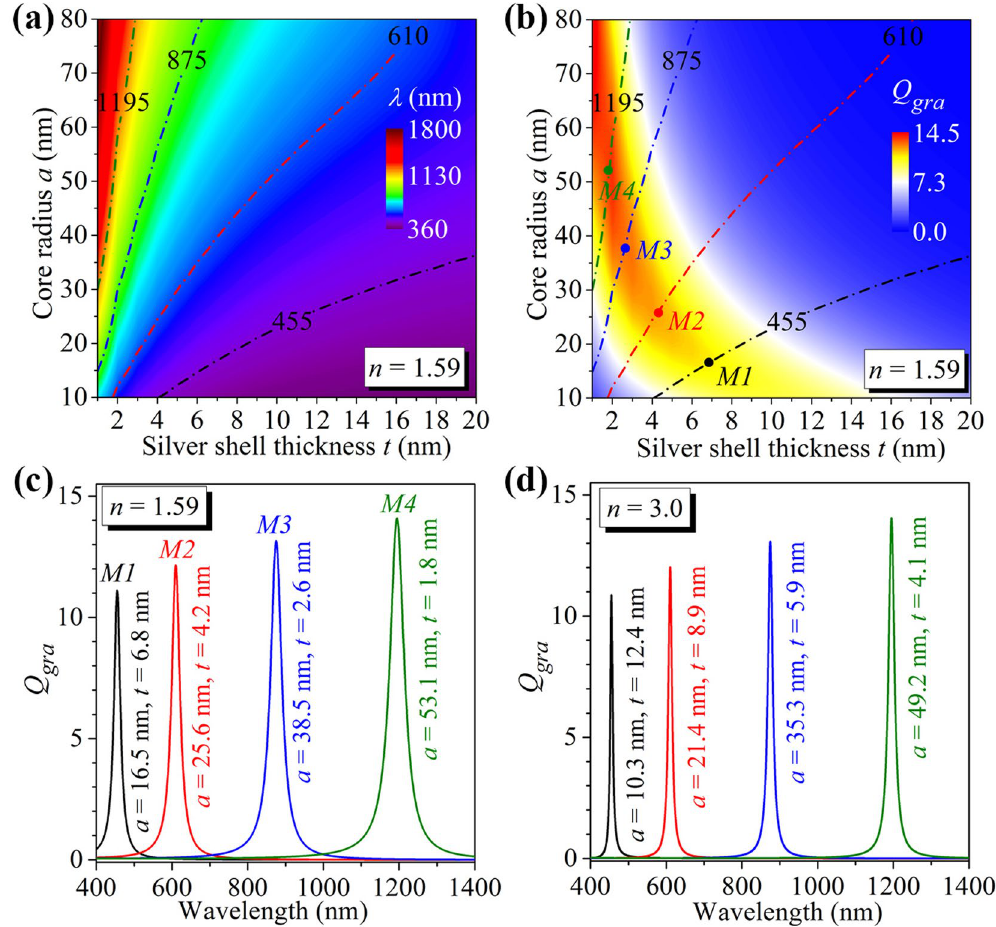
Figure 3. Two-dimensional colour map plot of spectral positions ( a ) and efficiencies ( b ) of the peaks that appear in the graphene absorption efficiency spectra calculated for the graphene-wrapped DMCSRs with the same core refractive index of n = 1.59 but different core sizes and silver shell thicknesses. Dashed lines in ( a ) and ( b ) outline the 455 nm (black), 610 nm (red), 875 nm (blue), and 1195 nm contours (green). Marked points M1, M2, M3 and M4 in ( b ) indicate the particular combinations of the silver shell thickness and the core radius where the graphene absorption efficiency can achieve the maximum value at the wavelengths of 455 nm, 610 nm, 875 nm and 1195 nm, respectively. ( c ) Graphene absorption efficiency spectra for the graphene- wrapped DMCSRs with fixed core refractive index of n = 1.59 and the optimized parameters corresponding to the marked points M1, M2, M3, and M4 in ( b ). ( d ) Graphene absorption efficiency spectra for the graphene- wrapped DMCSRs with fixed core refractive index of n = 3.0, in which the structural parameters are optimized so that the graphene absorption efficiencies can achieve the maximum values at the wavelengths of 455 nm, 610 nm, 875 nm and 1195